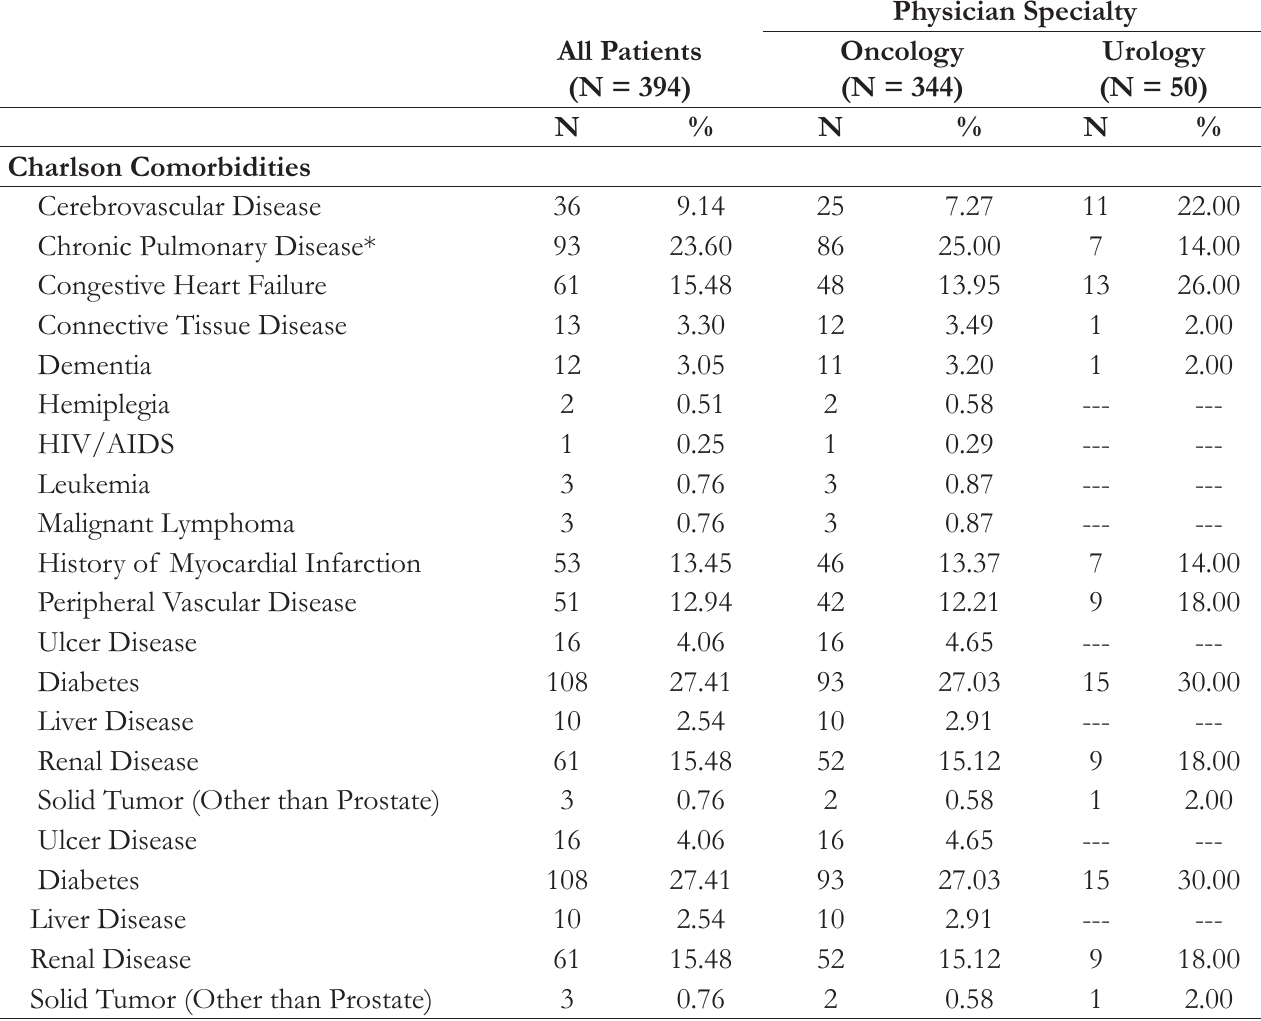
Table 1. P atient Characteristics, by Specialty of Treating Physician -